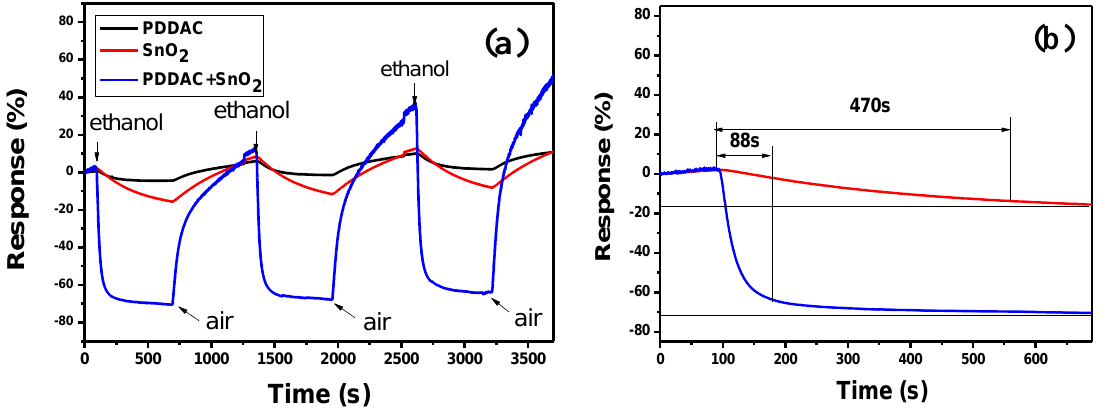
Figure 2. ( a ) Response of the SnO room temperature; ( b ) The response time of the SnO 150 ppm ethanol.